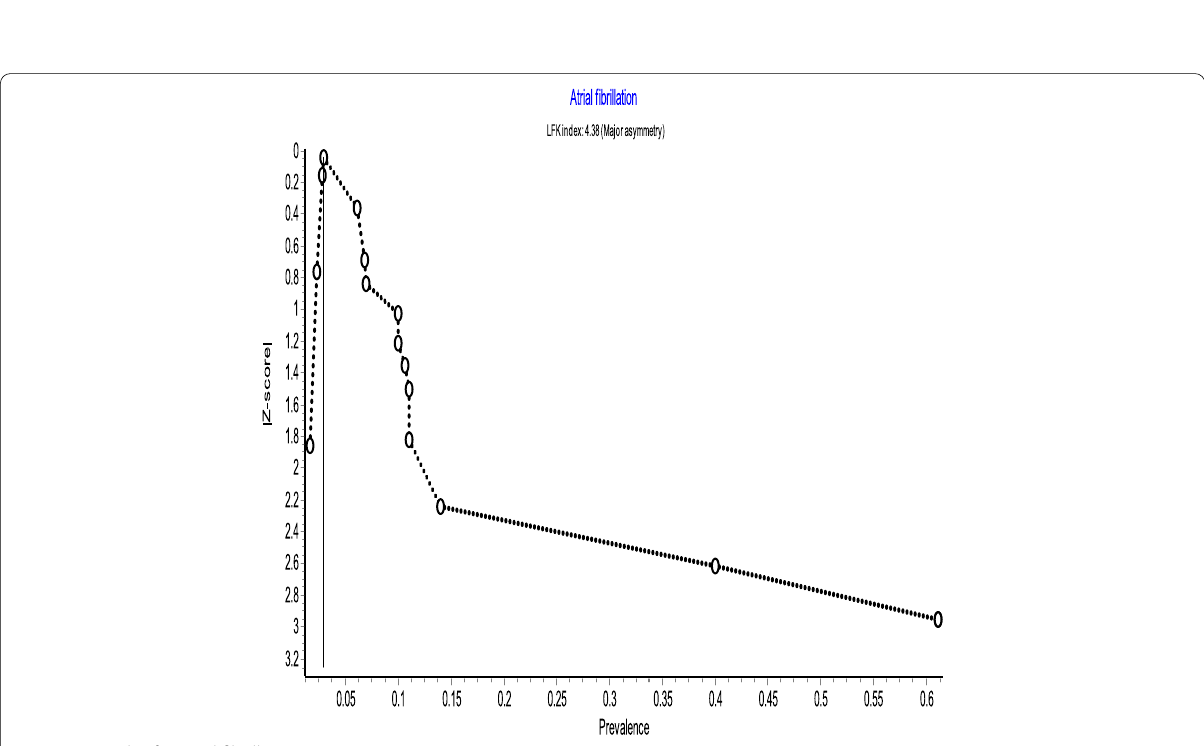
Fig. 19 Doi plot for atrial